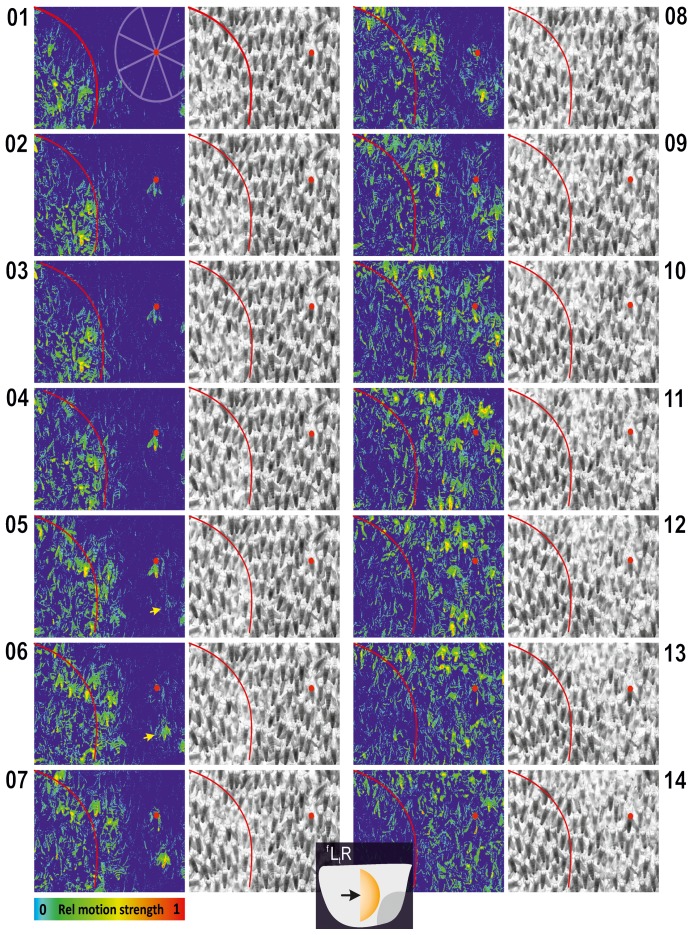
Propagation of a shimmering wave across the nest surface (detail view).The same wave is shown as in Fig. 3 but zoomed (for distance measures, see Fig. 1C). Continuous sequence of frames as pseudo coloured differential images and inverted video images; numbers (01–14) indicate the relative frame counts (fps = 60 Hz with interframe intervals of 16.67 ms). Scale below panel f 07 shows the relative motion strength (see Fig. 2). Red dots indicate the selected focus bee (the same as in Fig. 4) that started to flip her abdomen at f 02, acting as a generator bee for the subsequent daughter wave. One of her neighbours (marked with a yellow arrow) was passively shifted in f 05 and started the abdominal flip in f 06. The resulting daughter wave merged with the parental wave at f 10. The red curves on the left side of the images are shown for comparison with the initial position of the parental wave front as indicated in f 01.